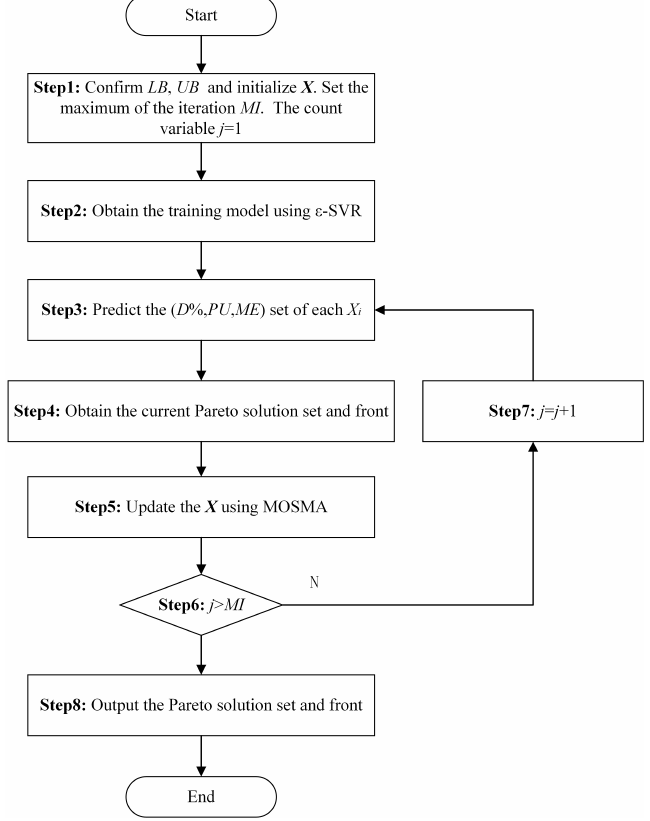
Figure 1. Flowchart of